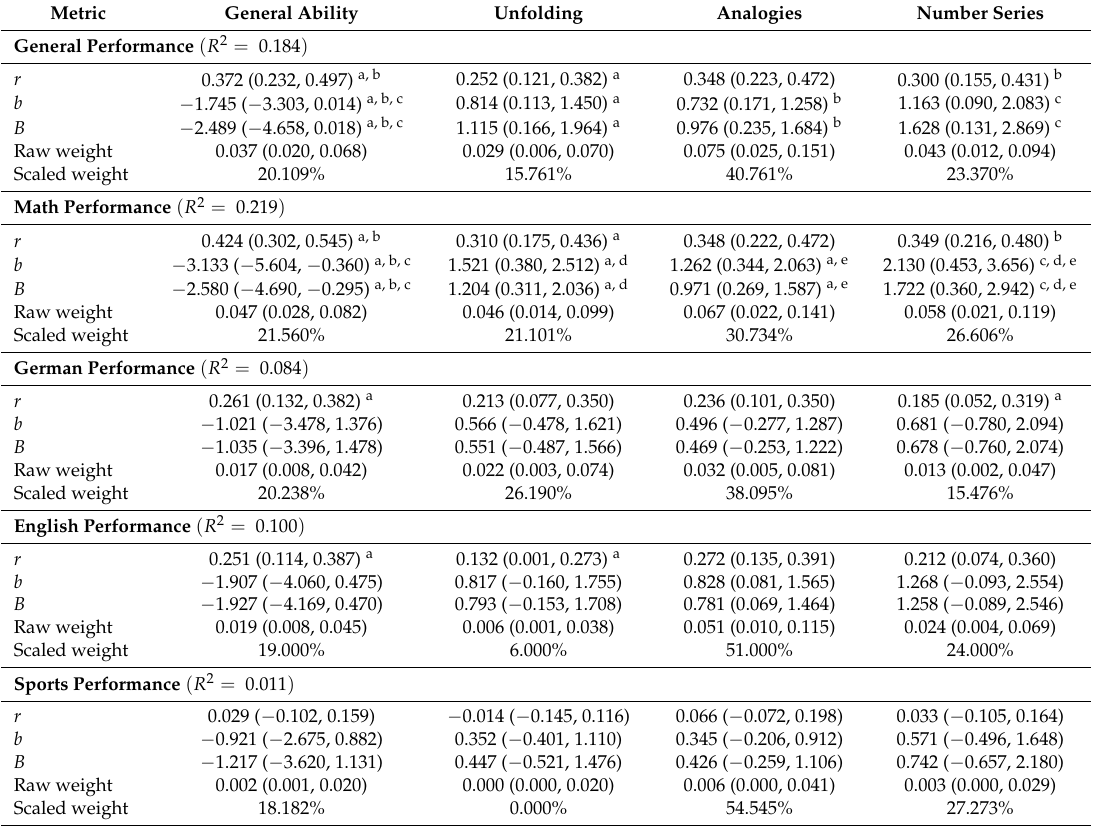
Table 3. Regression-based metrics of predictor variable